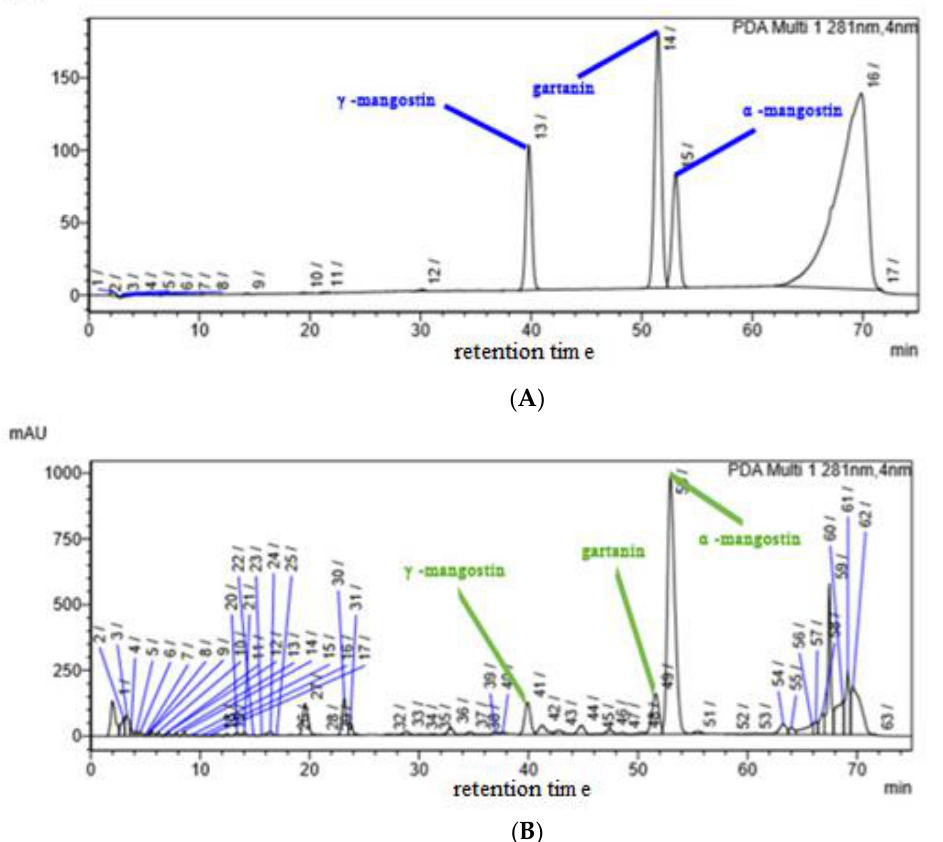
Figure 2. HPLC Chromatogram of reference standards ( A ) and samples of ethanolic extract of mangosteen ( B ). For condition, see text.